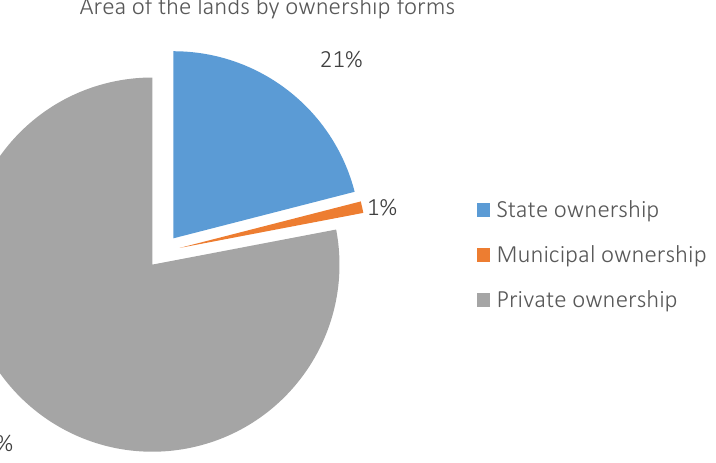
Figure 1. Analysis of land plots structure on Ukrainian territory